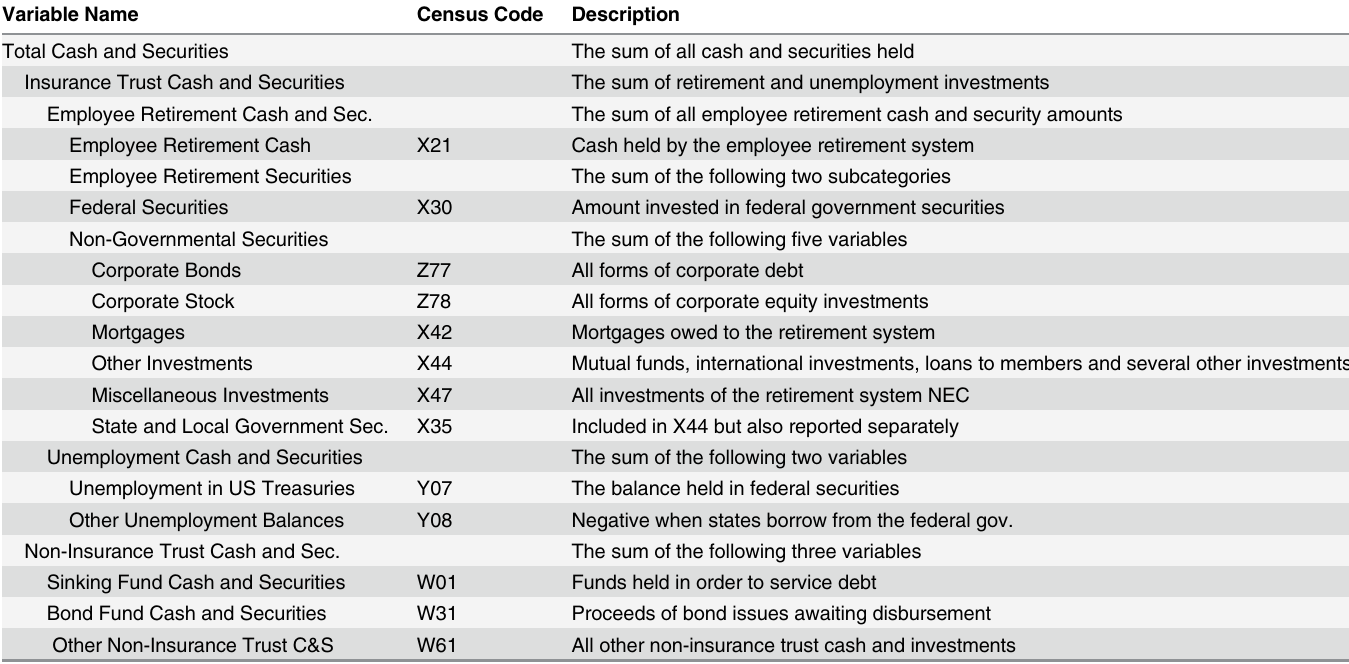
Table 9. Cash and Investment Security Variables.